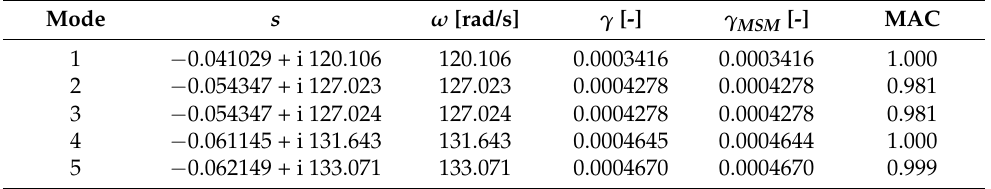
Table 5. Dome 4—NEP eigenvalues, natural frequency, non-dimensional damping ratio and